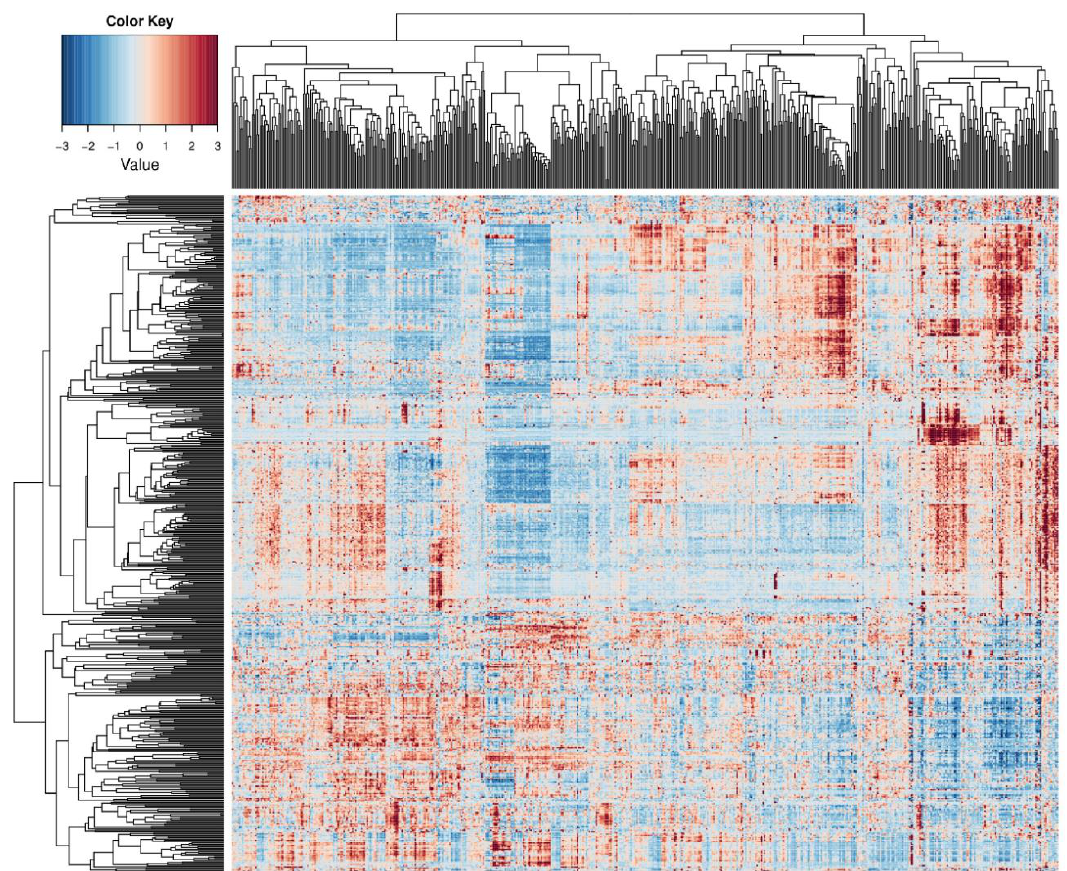
Figure 1. Heat map representation of differentially expressing miRNAs among glioblastoma (GBM) arrays (each array in the map represents an miRNA gene; due to more miRNA genes, gene names are not shown in the figure). Expression levels are scaled into log2 fold change and it scales from −3 (blue) downregulated, to 3 upregulated (brown). Top overexpressing miRNA genes selected from this matrix for further analysis.